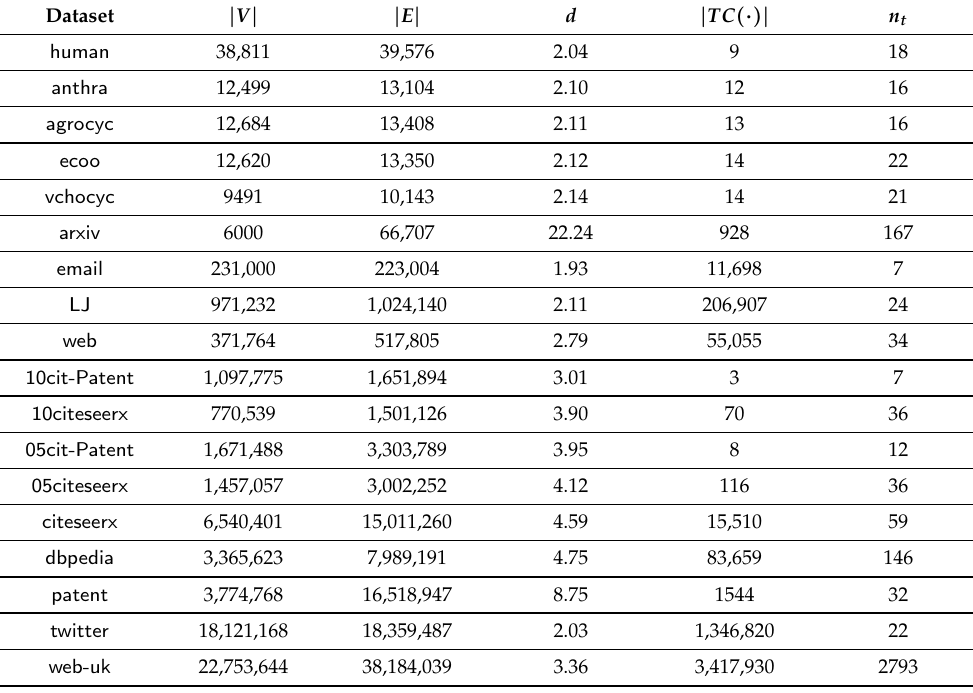
Table 3. Statistics of datasets, where d = 2 | E | / | V | is the average degree of G , | TC ( · ) | is the average number of reachable nodes for nodes of G , and n t is the number of topological levels (the length of the longest path) of G